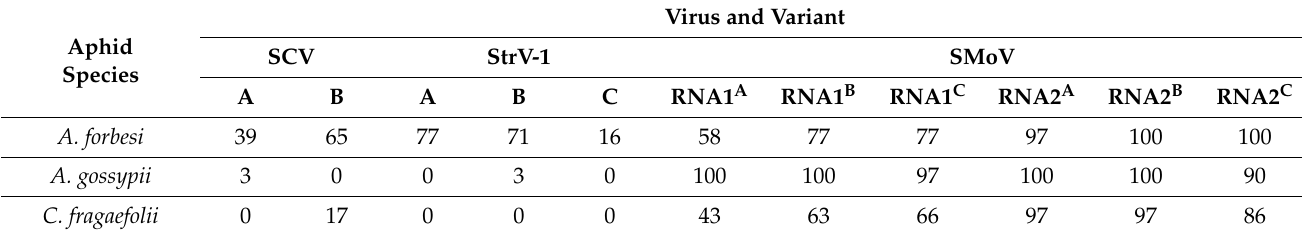
Figure 4. Overview of ∆ C q color-coded values for SCV, SMoV, StrV-1 and their variants in individual aphid adults for three species — A. forbesi ( n = 31), A. gossypii ( n = 31) and C. fragaefolii ( n = 35). Each row represents a single aphid. Refer to Table S5 for unfiltered data. Table 1. Summarized percentages of positive aphid individuals from Figure